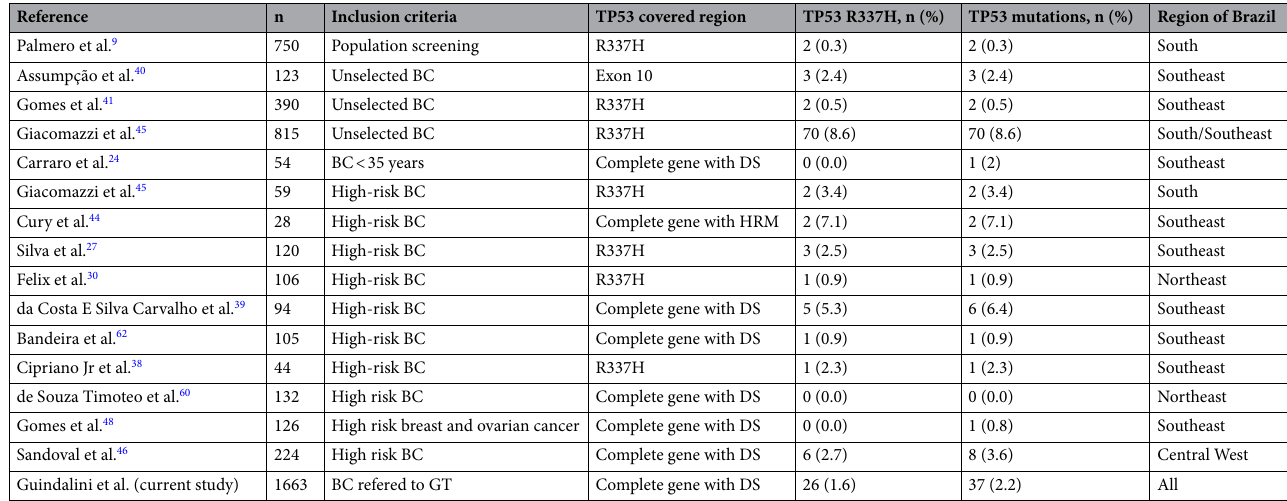
Table 4. Prevalence of TP53 germline variants in HBOC patients in Brazil. BC breast cancer, DS direct sequencing like Sanger or next generation sequencing (NGS), GT genetic testing, HRM high resolution